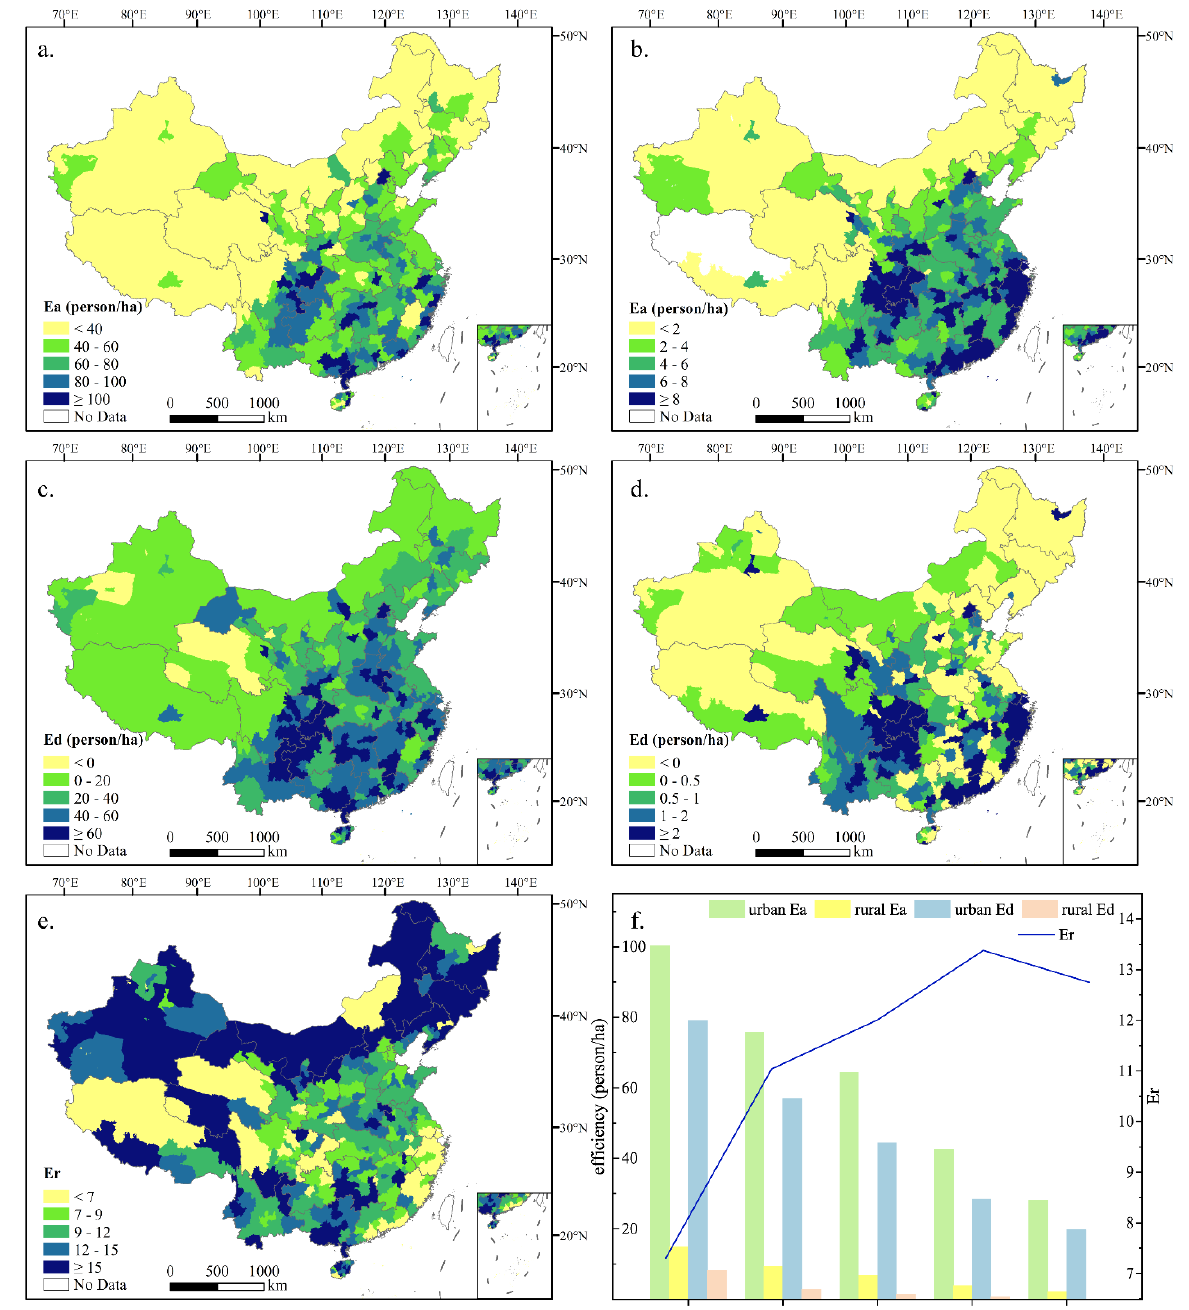
Figure 3. 𝐸𝑎 , 𝐸𝑑 , and 𝐸𝑟 in urban and rural areas of China. (a- 𝐸𝑎 in urban areas; b- 𝐸𝑎 in rural Figure 3. Ea , Ed , and Er in urban and rural areas of China. (( a )- Ea in urban areas; ( b )- Ea in rural areas; c- 𝐸𝑑 in urban areas; d- 𝐸𝑑 in rural areas; e- 𝐸𝑟 ; f- 𝐸𝑎 , 𝐸𝑑 , and 𝐸𝑟 in urban and rural areas of areas; ( c )- Ed in urban areas; ( d )- Ed in rural areas; ( e )- Er ; ( f )- Ea , Ed , and Er in urban and rural areas of cities for different sizes.) cities for different